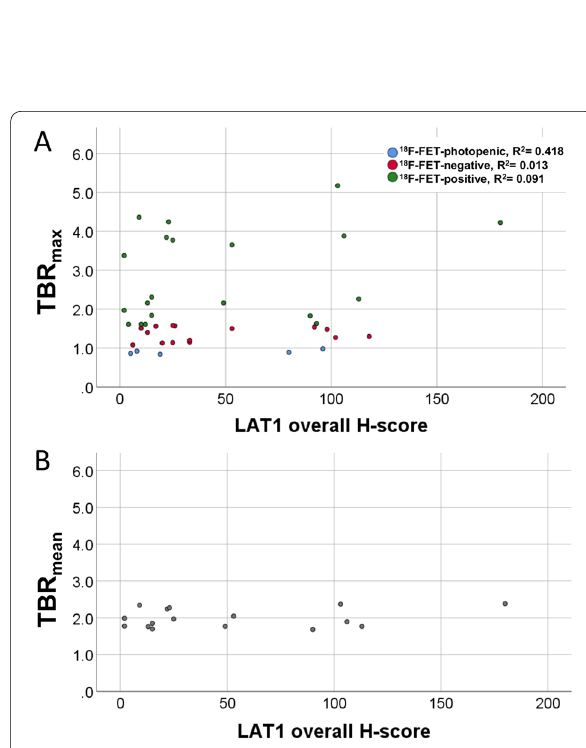
Fig. 3 Distribution of the TBR max ( A ) and TBR mean ( B ) over the LAT1 overall H‑score in the three groups of 18 F‑FET‑photopenic, 18 F‑FET‑negative and 18 F‑FET‑positive gliomas: no correlation was found for the LAT1 overall score and the 18 F‑FET‑PET parameter. R 2 values are displayed in the legend ( A